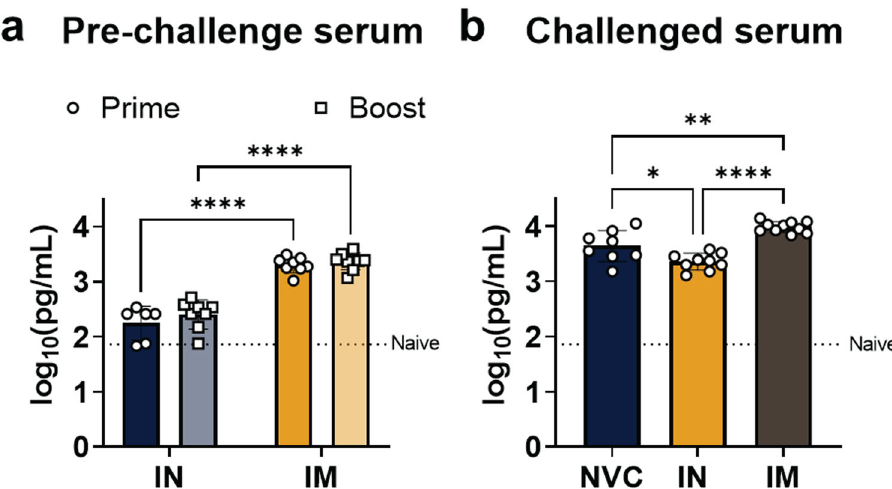
Fig. 7 Analysis of CXCL13 in serum in relation to immunization. a CXCL13 (log10 pg/mL) in pre-challenged serum. Two-way ANOVA with Sidak ’ s multiple comparisons test was performed for statistical analysis. P < 0.0001****. Naïve baseline represented as dotted line at 1.861183. b Post challenged CXCL13 levels in the serum. Ordinary one-way ANOVA with Tukey ’ s multiple comparisons test was performed for statistical analysis. P = 0.0112*, P = 0.0018**, and P < 0.0001****. All results represented as mean ±